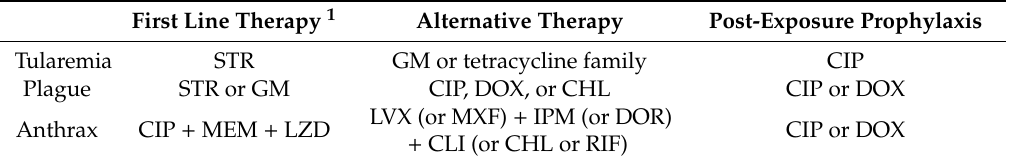
Table 1. Recommended therapeutic, prophylactic interventions for tularemia, plague, and